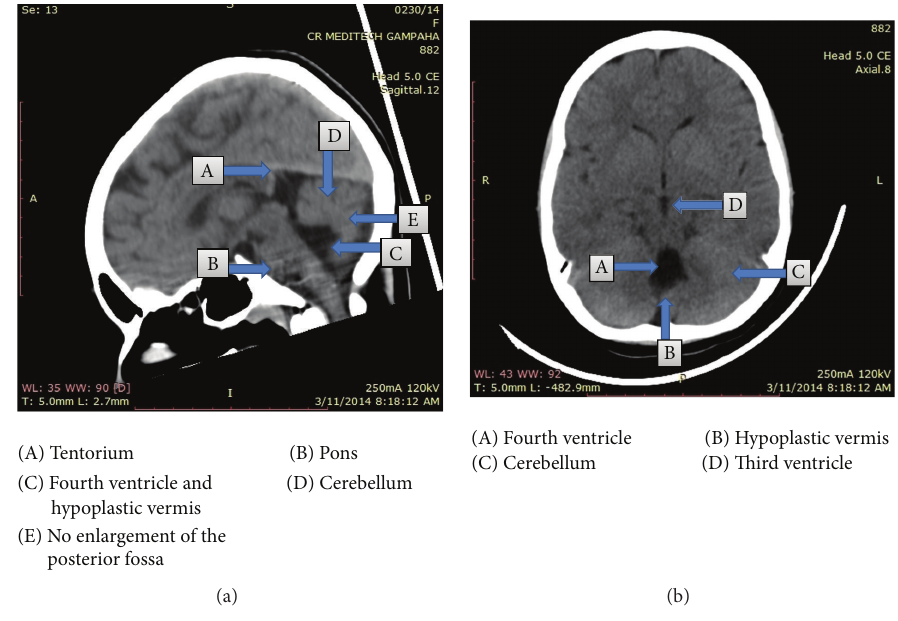
Figure 1: CT images of the patient, showing Dandy-Walker